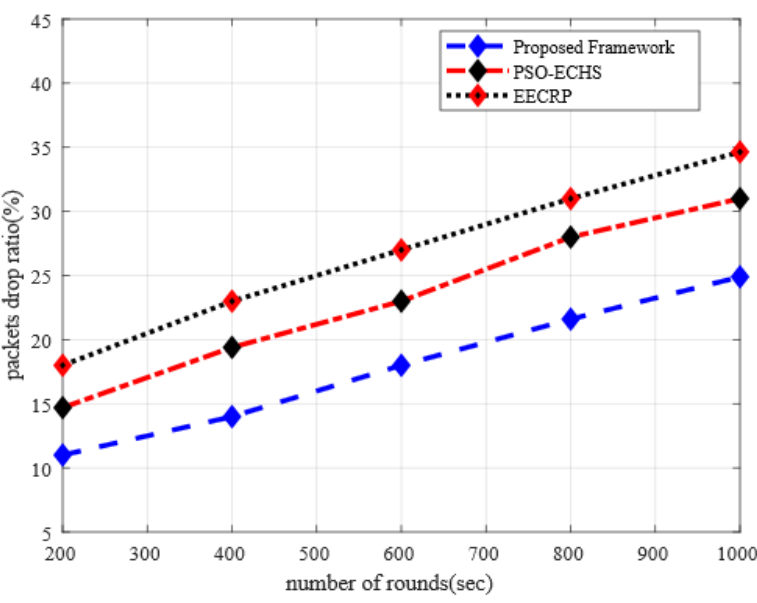
Figure 4. The impact of simulation rounds on the packets drop ratio.